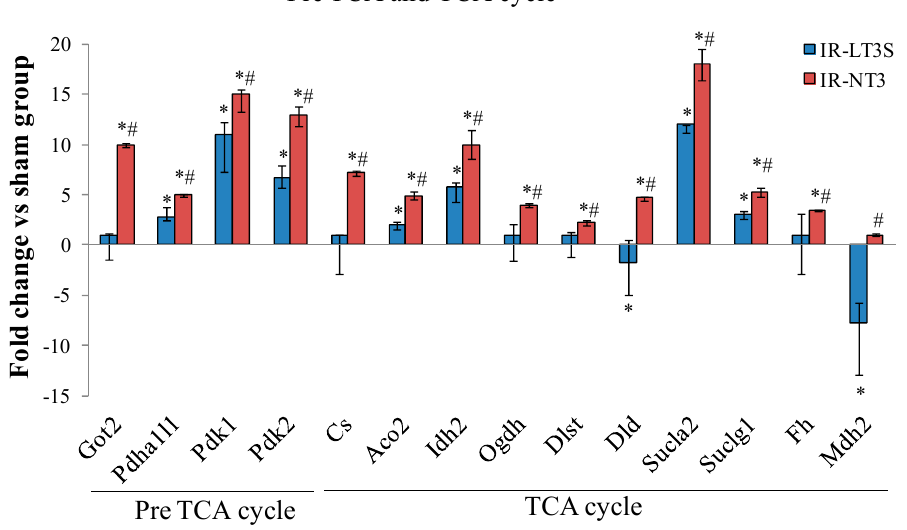
Figure 4. Differentially expressed proteins involved in TCA cycle and pre TCA cycle. Data are expressed as median and interquartile range. * p vs. sham < 0.017; # p vs. IR-LT3S < 0.017. Protein acronyms are listed in the abbreviation list.